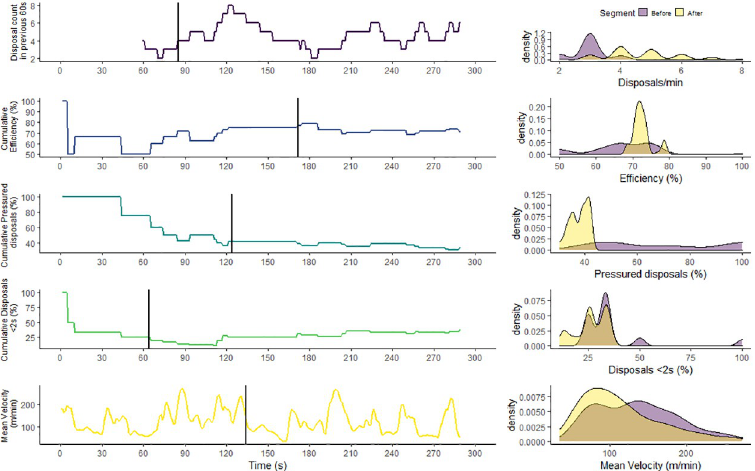
Fig 2. A univariate changepoint analysis of a single training activity. The left-hand column of panels displays the feature and the calculated changepoint location (black vertical line). The right-hand column of panels displays the distribution of the feature in each segment, before and after the